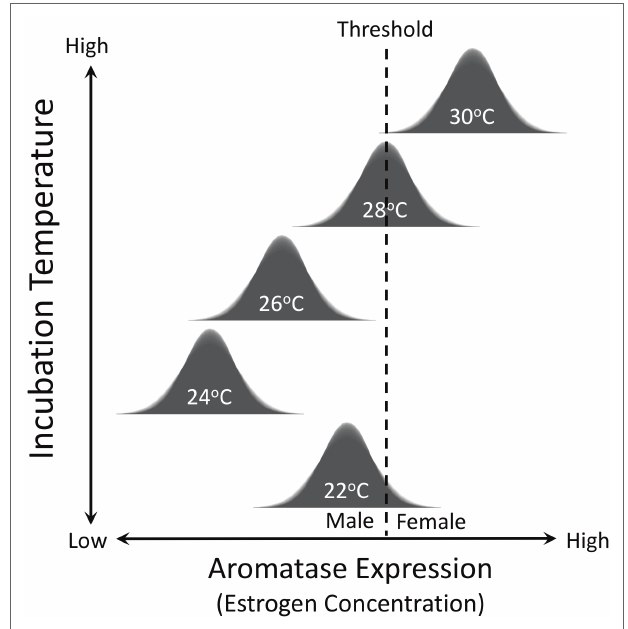
FIGURE 4 | Threshold model for temperature-dependent sex determination. Incubation temperature during development influences expression of the aromatase enzyme, which synthesizes estrogens. Variation in expression of aromatase enzyme and the concentration of estrogen is normally distributed at each incubation temperature. If estrogen concentration in embryonic gonads is below a critical threshold, gonads develop into testes. If they are above this threshold, gonads develop into ovaries.